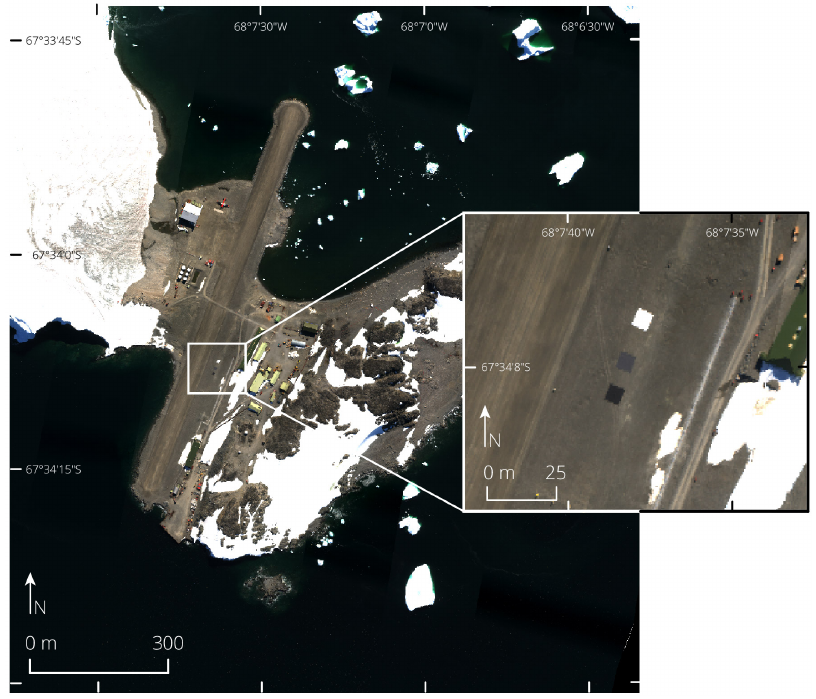
Figure 2. CASI colour composite image mosaic of Rothera Point following radiometric and geometric correction, with inset showing the three calibration targets. Bands shown: Red: 650.2 nm, Green: 554.6 nm, Blue: 439.6